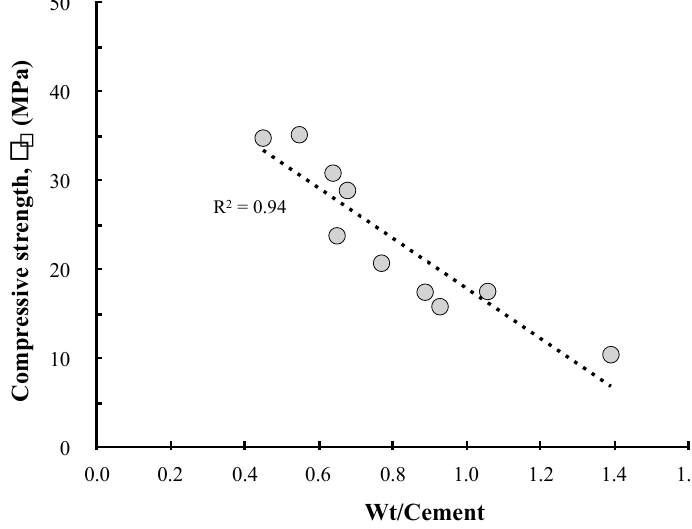
Figure 12. Variation of the compressive strength f